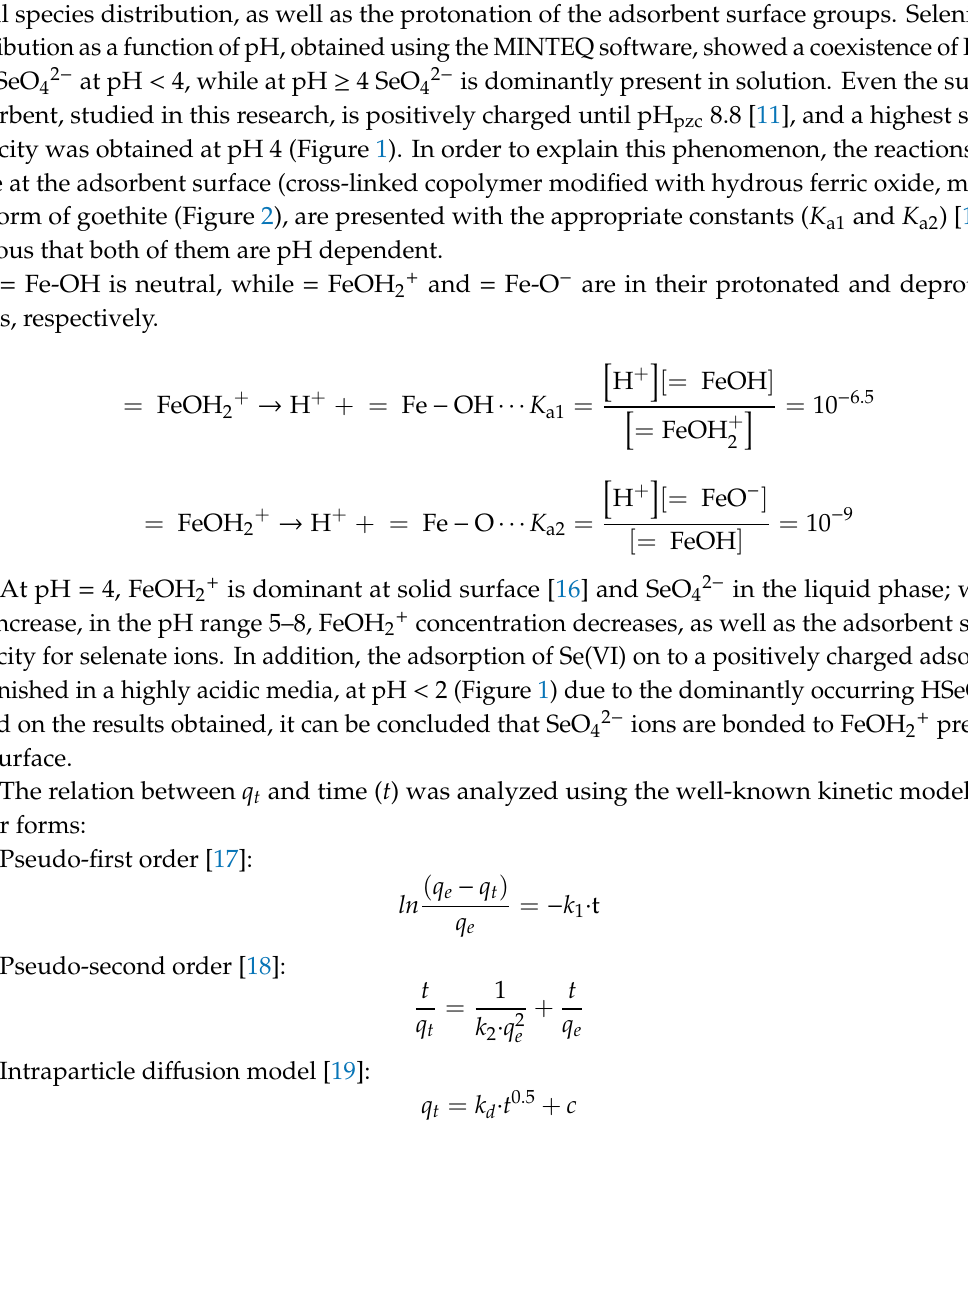
Removal E ffi ciency (%) 1 91 2 77.5 5 71 1 25 2 17.5 5 13 1 14 2 8